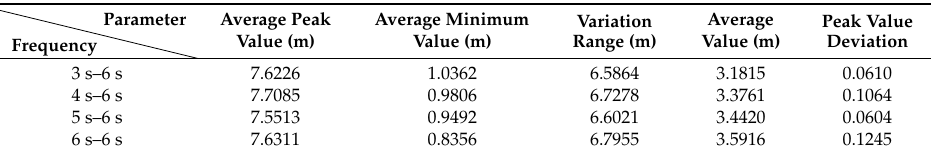
Table 9. Pressure values and statistical analysis after air inflow has been cut off for 6 s when the slot nozzle is set in the middle of the pipe.